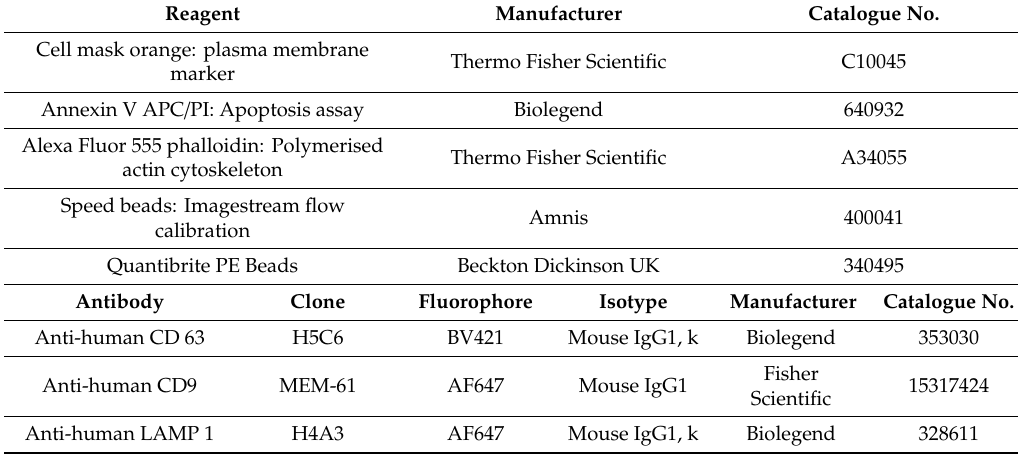
Table 2. Chemicals and Reagents Including Antibodies.